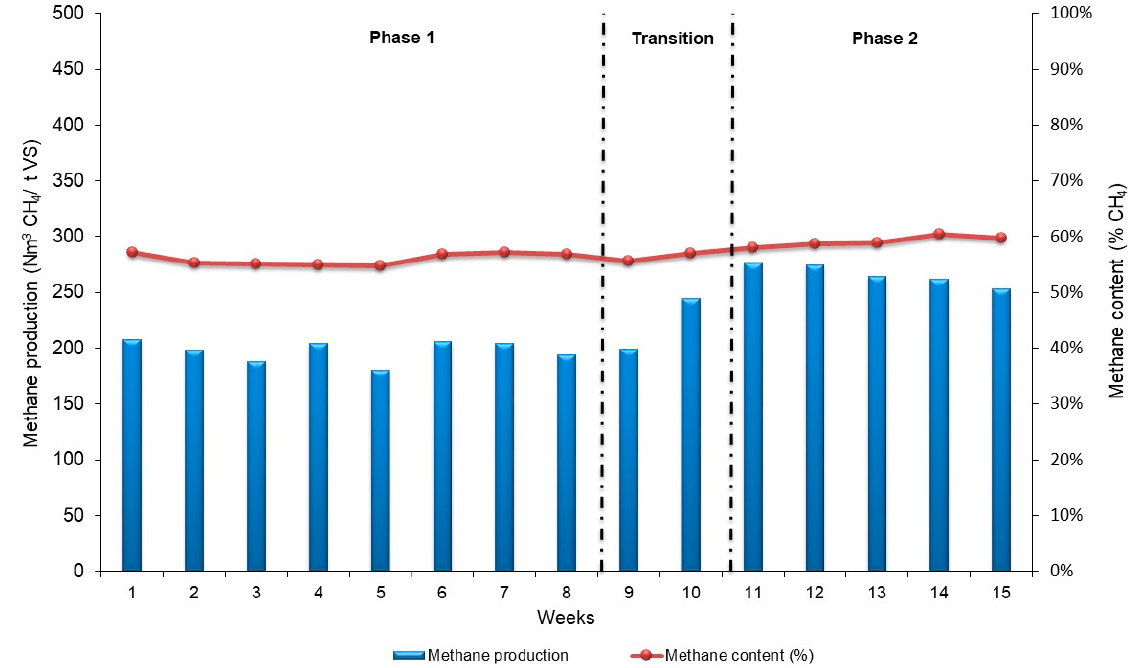
Energies 2021 , 14 , 5391 10 of 15